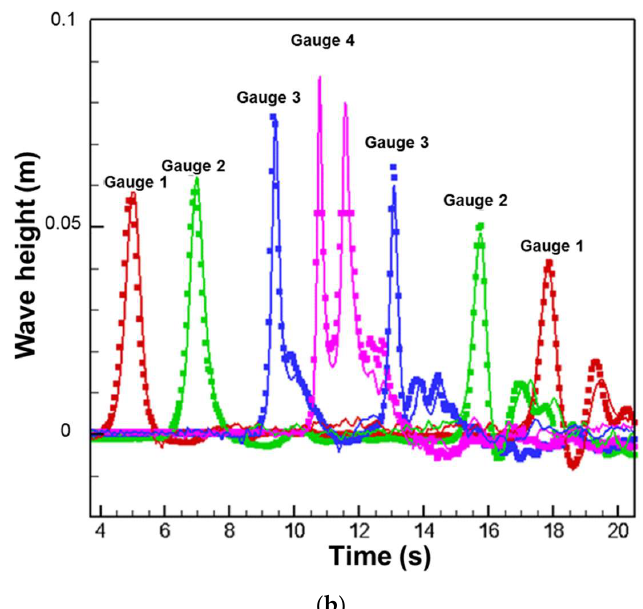
Figure 15. Time history of wave height for case 1 with particle sizes of ( a ) 0.005 m and ( b ) 0.0025 m (solid lines: numerical simulated results, symbols: hydraulic experiments).